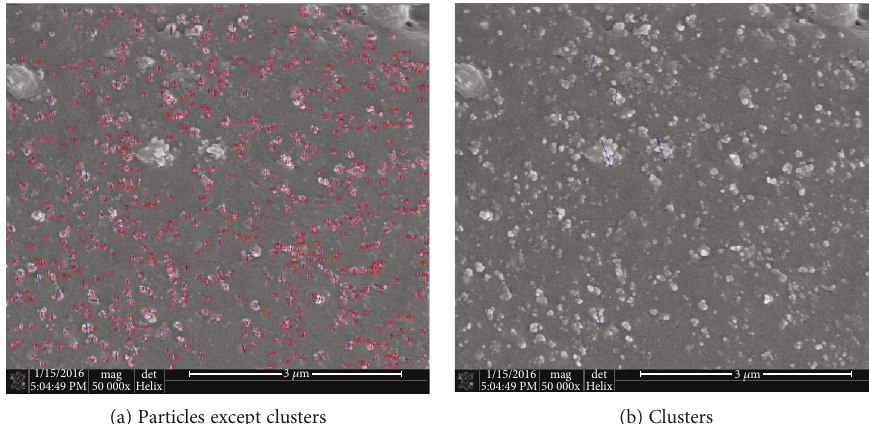
Figure 2: Particle size and number analysis of NSBR6 rubber.